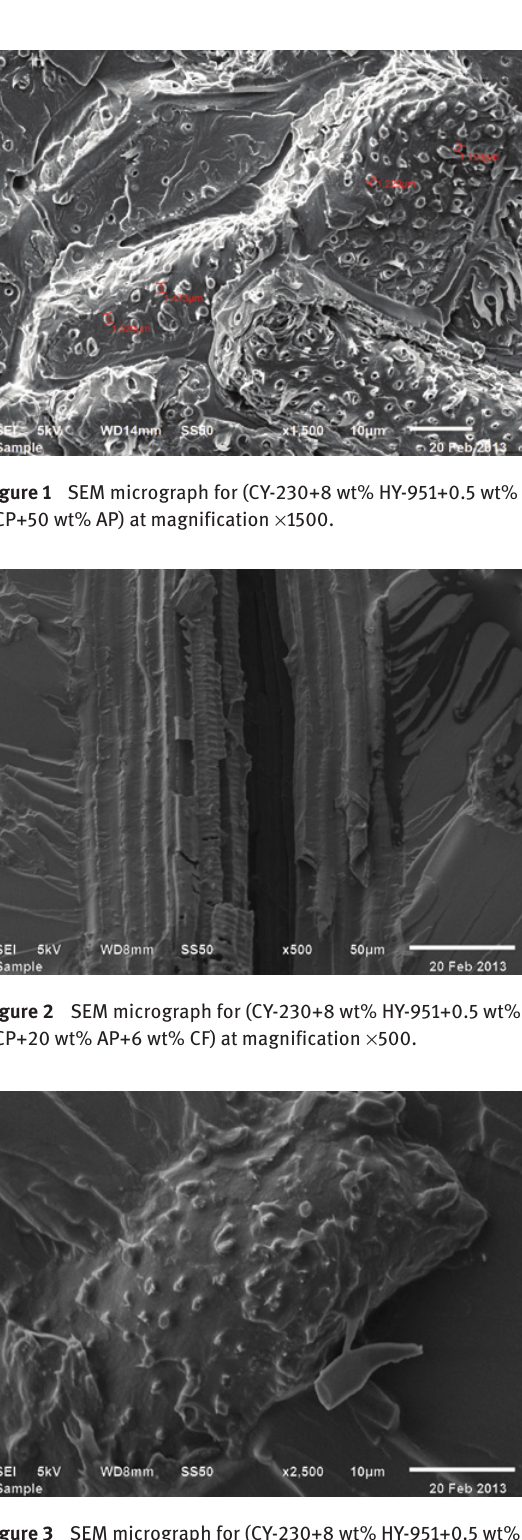
16.125 to 25.864 μ m. In all figures particle pullout and fiber either pullout or broken perpendicular to the fiber